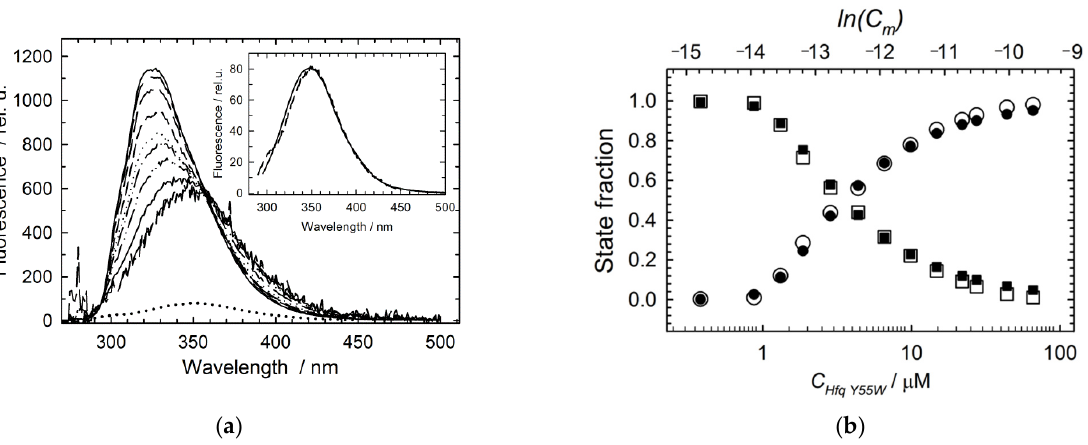
Figure 5. Disassembly of Hfq Y55W in the presence of 1.6 M GuHCl by decreasing protein concentration: ( a ) The set of selected fluorescence spectra of Hfq Y55W at various protein (monomer) concentrations (from the top line to the bottom line—65 μ M, 22 μ M, 10 μ M, 6.5 μ M, 4.4 μ M, 2.8 μ M, 1.9 μ M, 1.3 μ M, 0.87 μ M, 0.38 μ M). The spectra are standardized to the same concentration (65 μ M). At the inset: the basic spectrum of the triple mutant (solid line) assumed in fluorescence spectra deconvolution, and the spectrum of the intermediate, obtained by the dilution down to 0.38 μ M at 1.6 M GuHCl (dashed line); ( b ) The dependence of the state fractions on the molar protein (monomer) concentration determined by deconvolution of the fluorescence spectra. The fractions of the native (hexameric) and intermediate states are shown by filled circles and filled squares, respectively. The open symbols are the prediction of the state distribution obtained from simulations based on the parameters from Table 2. The buffer contains 20 mM Tris-HCl, pH 7.5, and 1.6 M GuHCl.